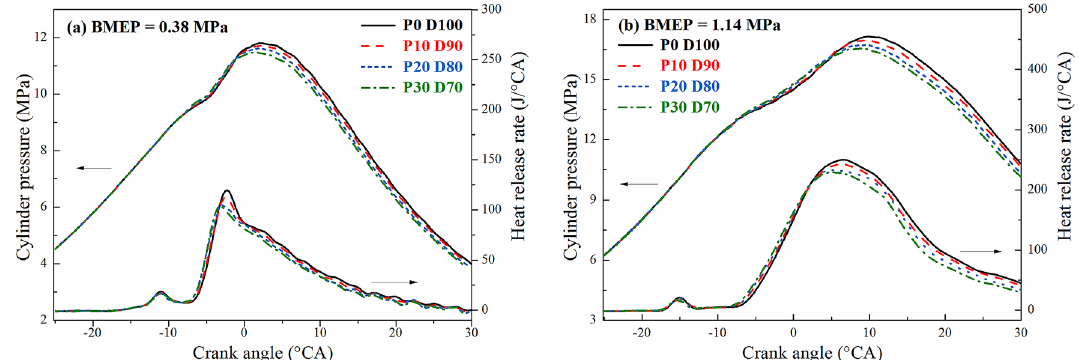
Figure 2. Effects of PODE n blending ratio on in-cylinder pressure and instantaneous heat release